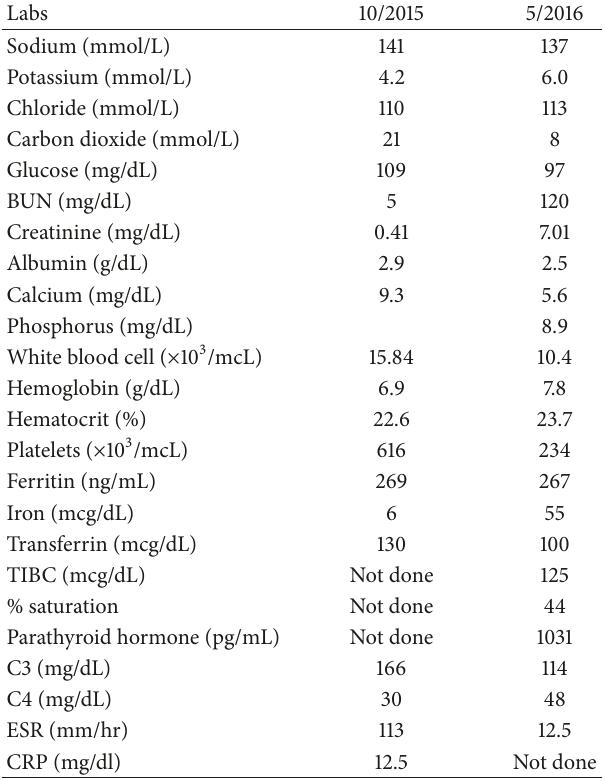
Table 1: Comparison of lab values between prior and current admission.